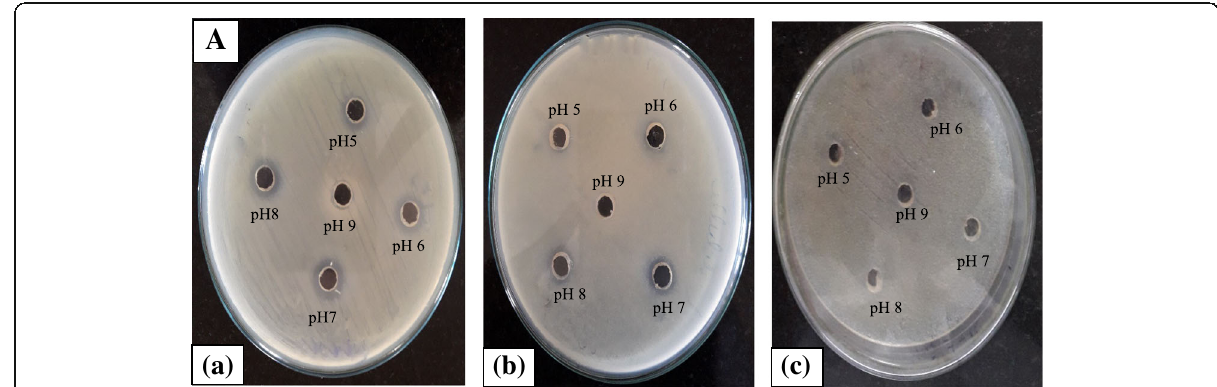
Fig. 2 A Effect of pH on bacteriocin production after 24 h against (a) P. aeruginosa , (b) S. aureus , and (c) E.coli at 37